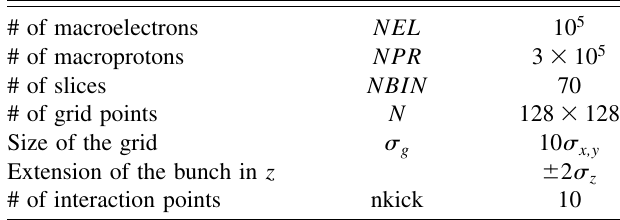
TABLE II. Computational parameters.